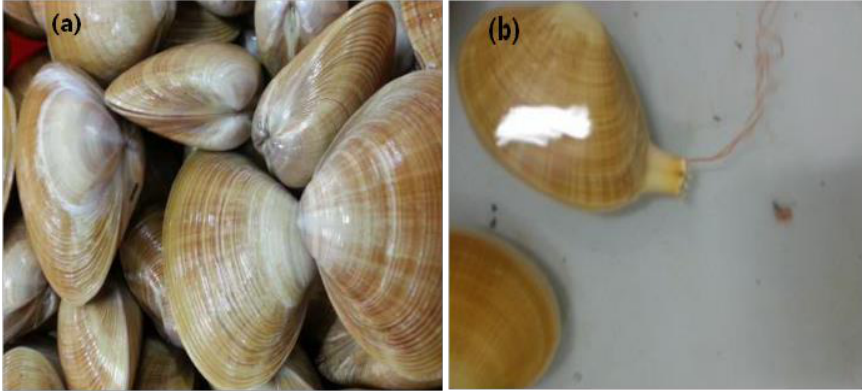
Figure 1. Female and male Mactra chinensis used in the experiment ( a ); and M. chinensis spawning ( b